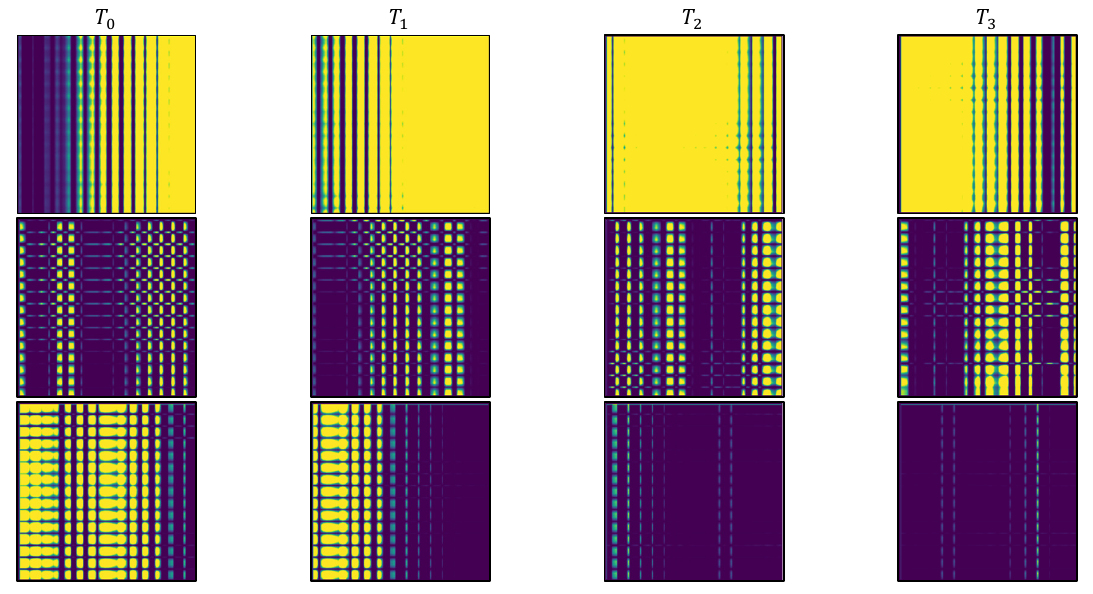
Figure 6. Examples of sequential 𝑆𝐵𝐼𝐷𝑃 .